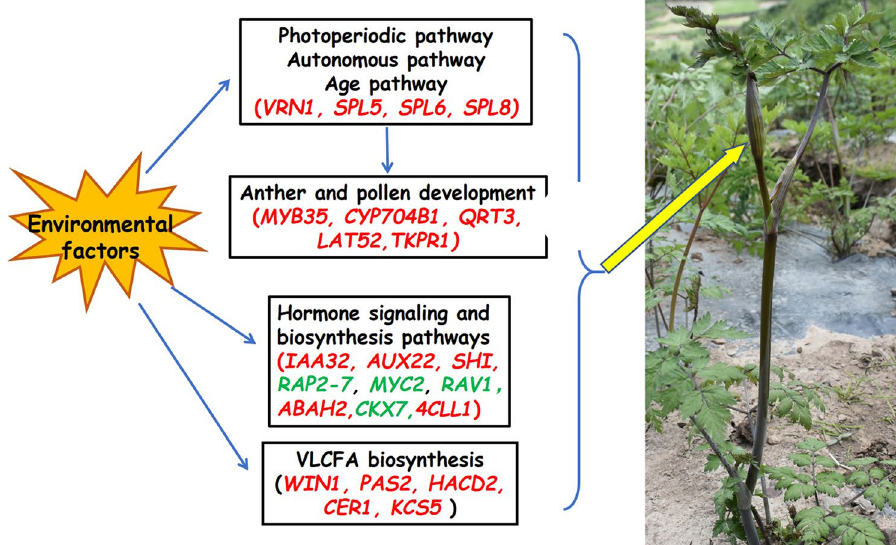
Figure 7. The putative genes interaction model for early bolting of A. sinensis in the natural environment. The early bolting process of A. sinensis involves the transformation of different development patterns, the development of flower organs, and the interaction of signal pathways controlled by the environment and another endogenous